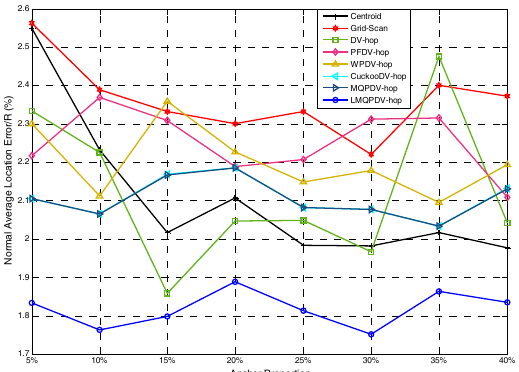
Figure 11. Communication range 200for WSN#1. Sensors 2019 , 19 , x FOR PEER REVIEW